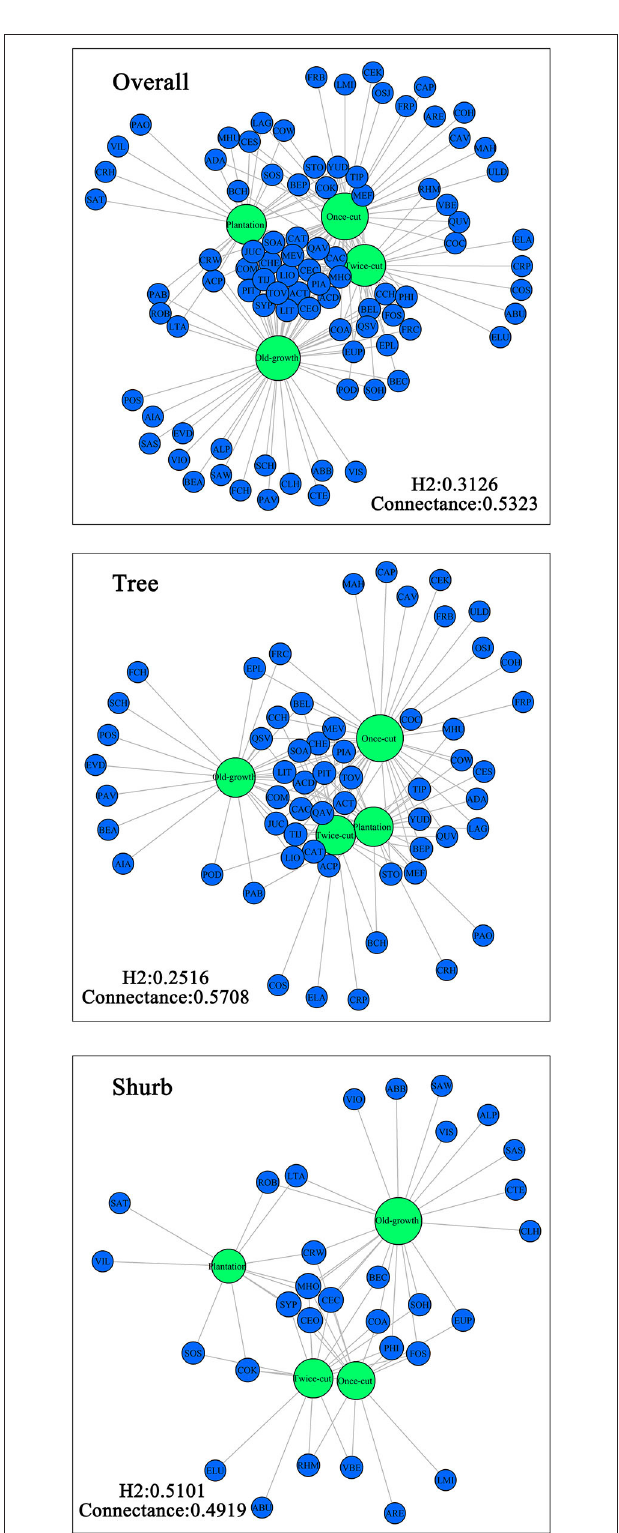
FIGURE 6 | Network analysis of species composition among the four communities. The size of the dot indicates the abundance of species. Green circles indicate communities, and blue circles indicate species.